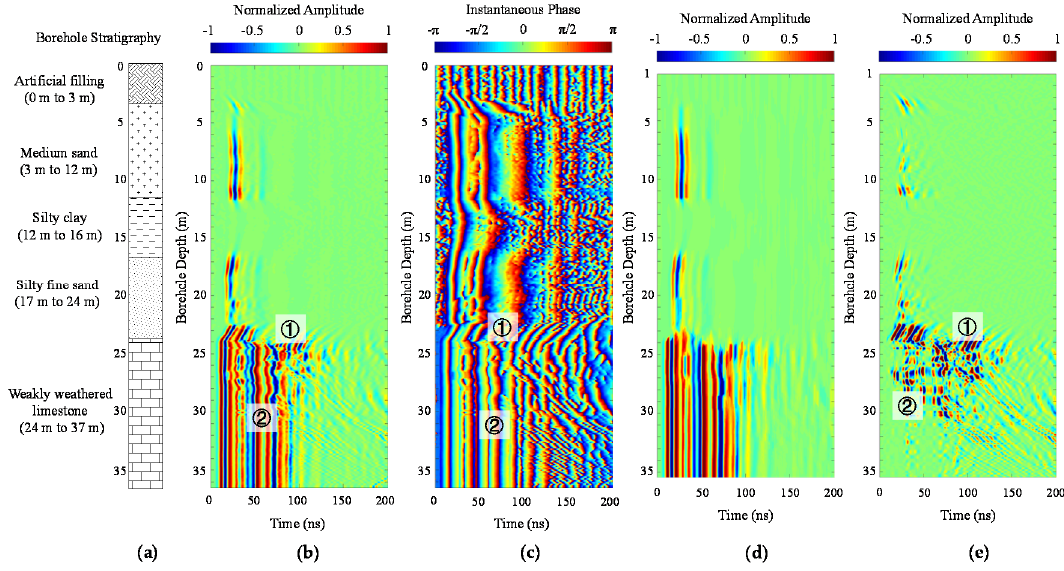
Figure 9. Single borehole GPR detection data on a typical rock fracture borehole scenario. ( a ) No. ZK-4-36 borehole stratigraphy; ( b ) radar data; ( c ) instantaneous phase; ( d ) removed wave profile using median filtering; ( e ) median filtered wave.